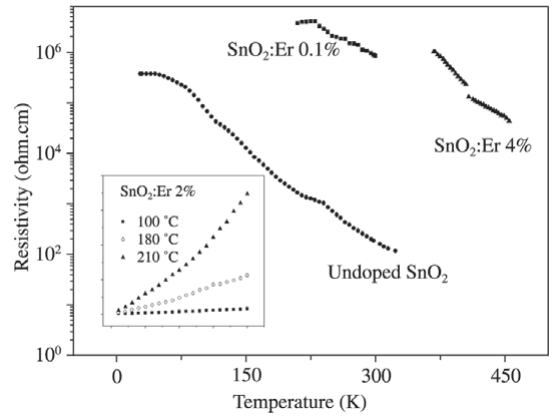
Figure 2. Resistivity as function of temperature for some Er-doped thin films. Inset-Current-voltage characteristics above room tem- perature for SnO :2%Er. 2